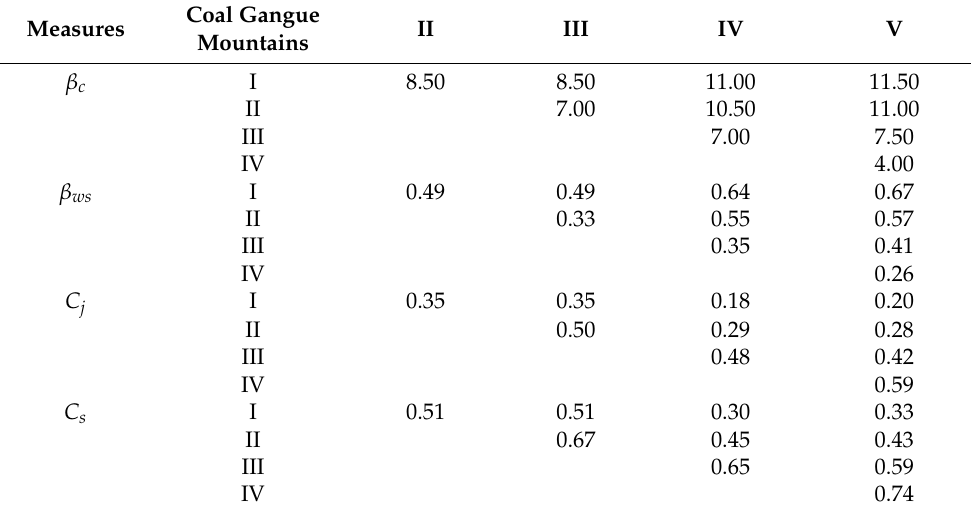
Table 4. β diversity matrix of plant communities in different coal gangue mountains.